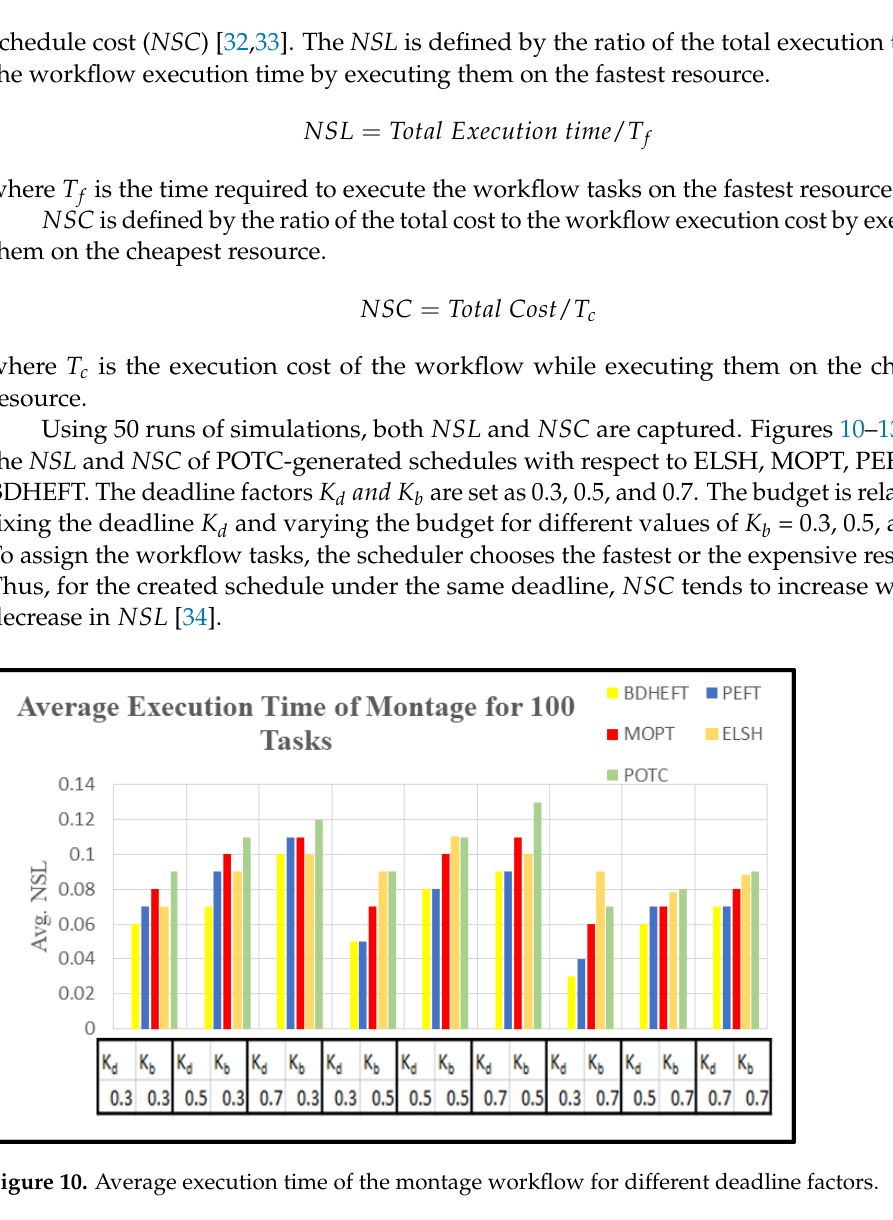
Figure 11. Average execution cost of the montage workflow for different deadline factors.